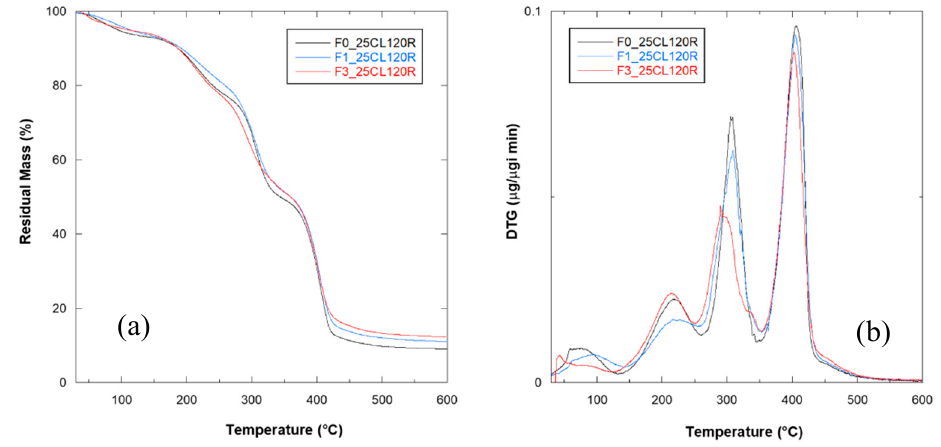
Figure 7. TG ( a ) and DTG ( b ) curves for TPWF / PCL blends based on F0, F1 and F3 flours, containing 25% wt. of PCL and processed at 120 rpm.